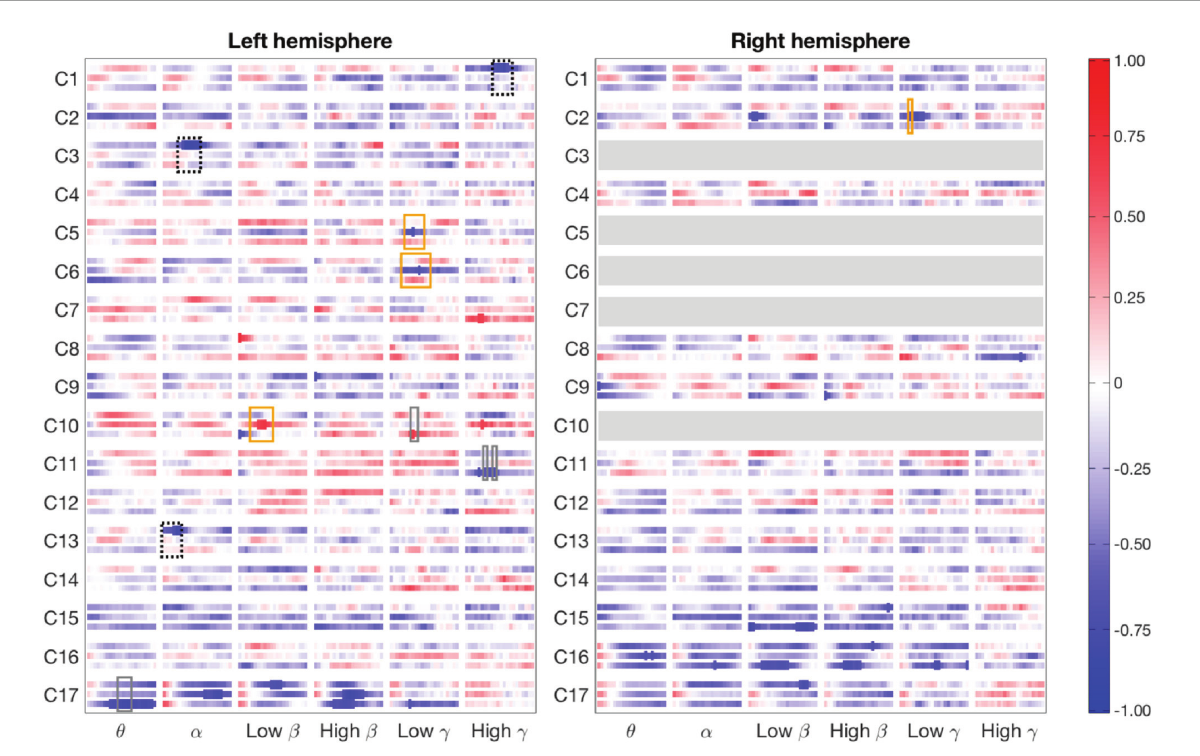
FIGURE4 Magnetoencephalography-Functional magnetic resonance imaging correlation patterns divided into clusters (row labels) and hemispheres (left and right panels). The three rows in each cluster show correlation between fMRI and MEG for the three experimental conditions: from top to bottom, object naming from object images, action naming from action images and object naming from action images, over time in the different frequency bands (column labels). Significant correlations ( p = 0.05, Bonferroni-corrected over the 22 time points) are marked as thicker parts of stripes. Rectangles indicate areas where the 99% confidence intervals of one condition do not overlap those of the other two conditions. A salient difference between naming tasks (naming actions vs. objects) is denoted by an orange rectangle, a difference between two picture types (action vs. object stimulus) is indicated by a dotted black rectangle, and a difference specific to naming objects from action images vs. the other two tasks with a gray rectangle. A rectangle is shown only when there is also a significant MEG–fMRI correlation inside the rectangle. Clusters C3, C5-C7, and C10 have parcels only in the left hemisphere (blank gray bars in the